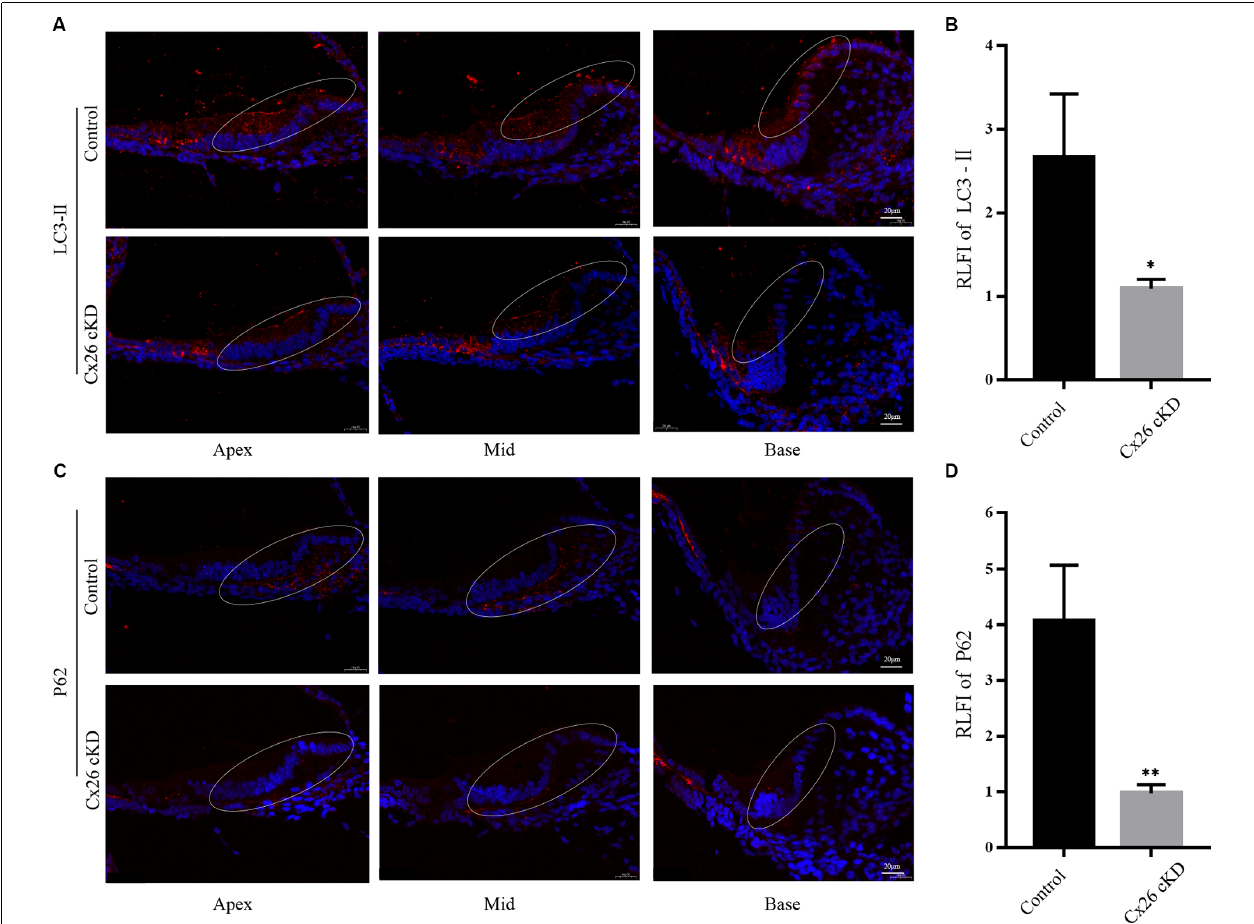
FIGURE 3 | Autophagy of Kölliker’s organ was detected by immunofluorescence staining at P1. (A) In the apical, middle, and basal turns, immunoreactivity of LC3-II was intense in Kölliker’s organ of the control group and markedly less intense in the Cx26-cKD group. Scale bars = 50 µ m. (B) Average relative fluorescence intensity (RLFI) of LC3-II signal; ∗ represents P < 0.05, n = 3. (C) Immunofluorescence staining of p62 was attenuated in Kölliker’s organ cells of apical, middle, and basal turns in the Cx26-cKD group compared with the control group. Scale bars = 50 µ m. (D) Average relative fluorescence intensity (RLFI) of p62; ∗∗ represents P < 0.001, n =